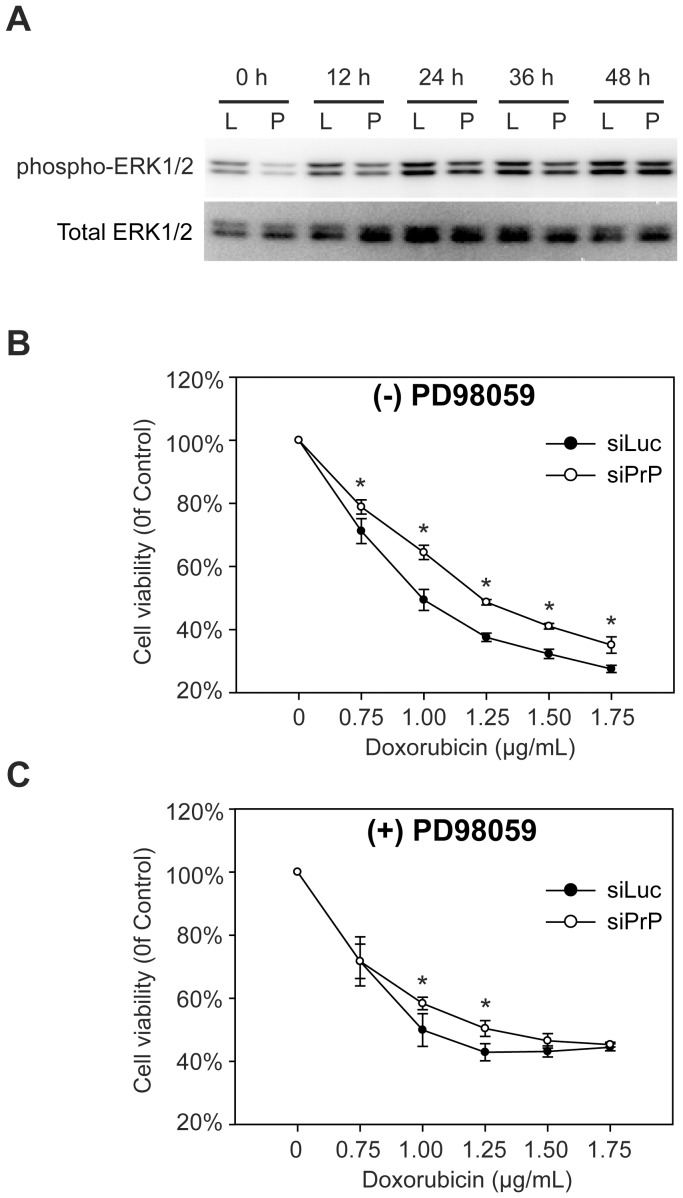
ERK signaling pathway is involved in PrP knockdown induced resistance to doxorubicin.(A) Immunoblot analysis of the phosphorylated ERK1/2 (phospho-ERK1/2) and total ERK1/2 after incubation with 1.25 µg/mL doxorubicin for indicated time. L, siLuc cells; P, siPrP cells. Cells without (B) or with (C) pre-incubation with PD98059 were incubated with doxorubicin for 48 hours at indicated concentrations and cell viability was measured by the MTT assay. Asterisks represent statistically significant differences, which were determined by student's t test and indicated by * P<0.05.